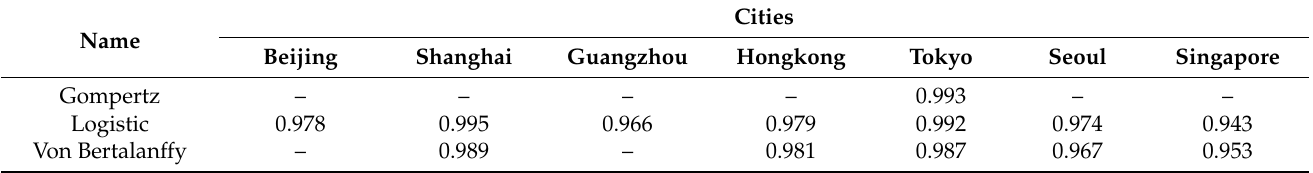
Table 3. Fitting results of network scale growth curves with the three kinds of S-type curves.